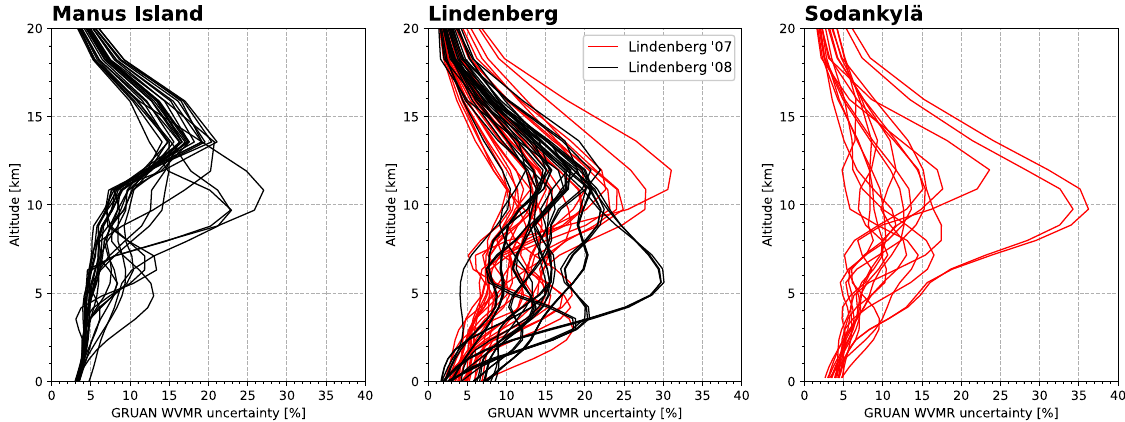
Figure A2. Same as top panels of Fig. A1, but for the correlated errors in the regridded and smoothed GRUAN radiosonde